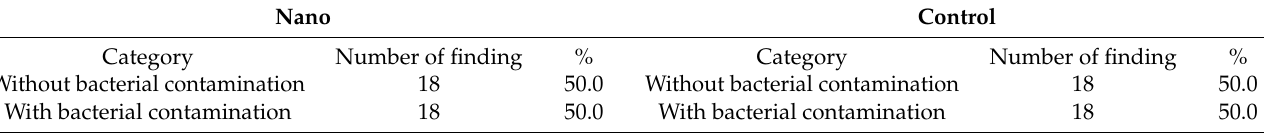
Table 3. Culture results in boxes for storing medical